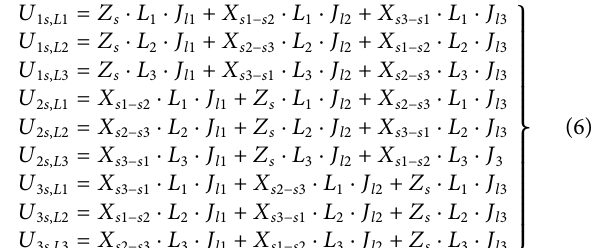
FIGURE 3 | Simpli fi ed cross connect con fi